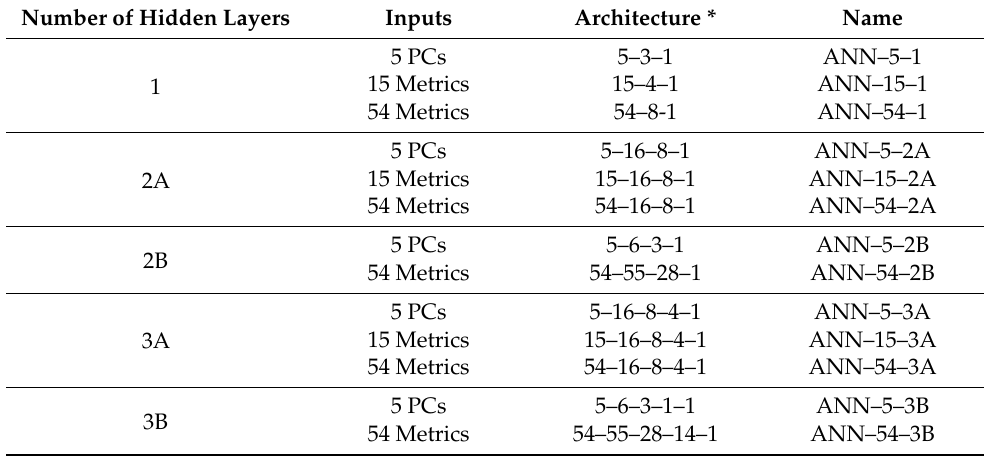
Table 3. Summary of the architectures adopted for modeling using artificial neural networks (ANNs). Number of Hidden Layers Inputs Architecture